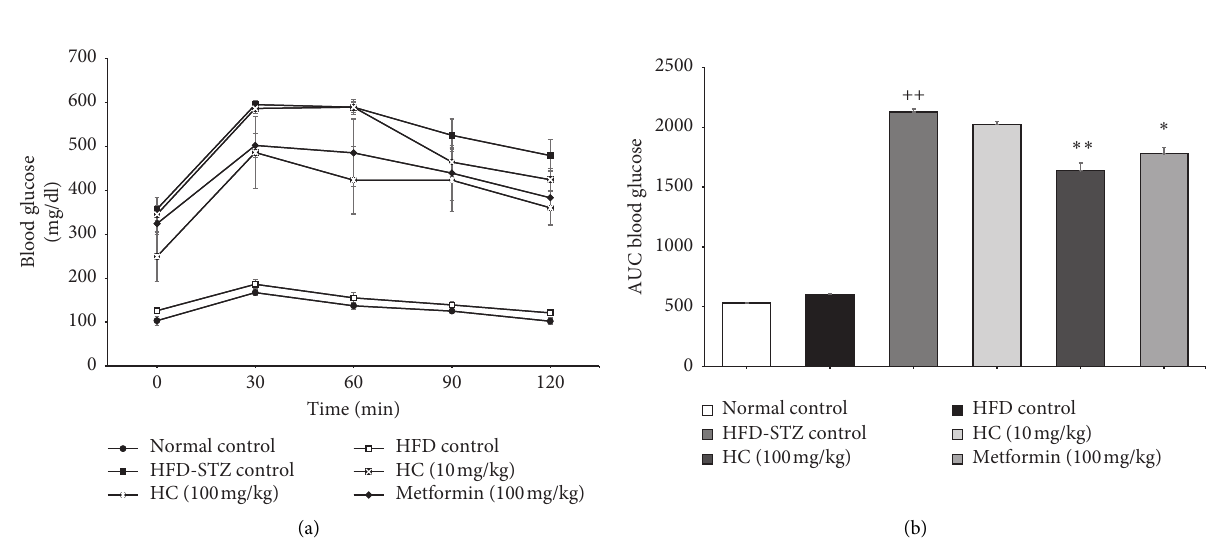
Figure 4: Effect of HC on glucose tolerance in diabetic rats. (a) Oral glucose tolerance test curves of rats determined during the last weeks of the experiment; (b) area under the curve. ++ p < 0 . 001 versus normal control group. ∗ p < 0 . 001 and ∗∗ p < 0 . 001 versus HFD-STZ control group. Results are presented as means ± SD ( n � 6 each